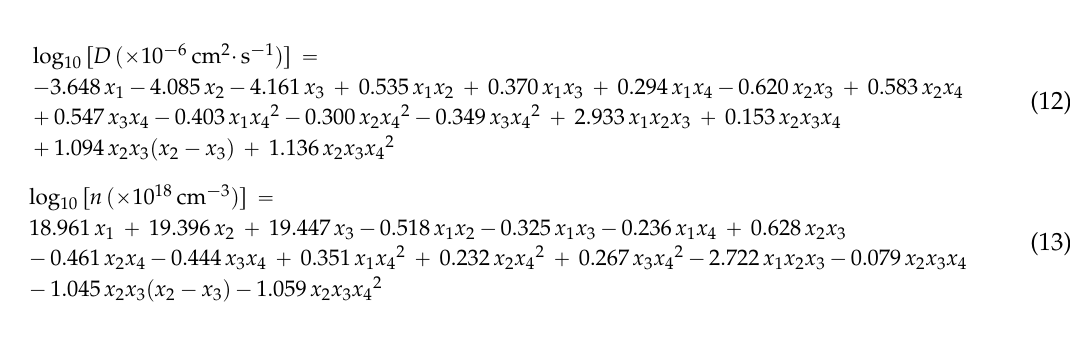
Table 2. Optimized models for each of the response properties.